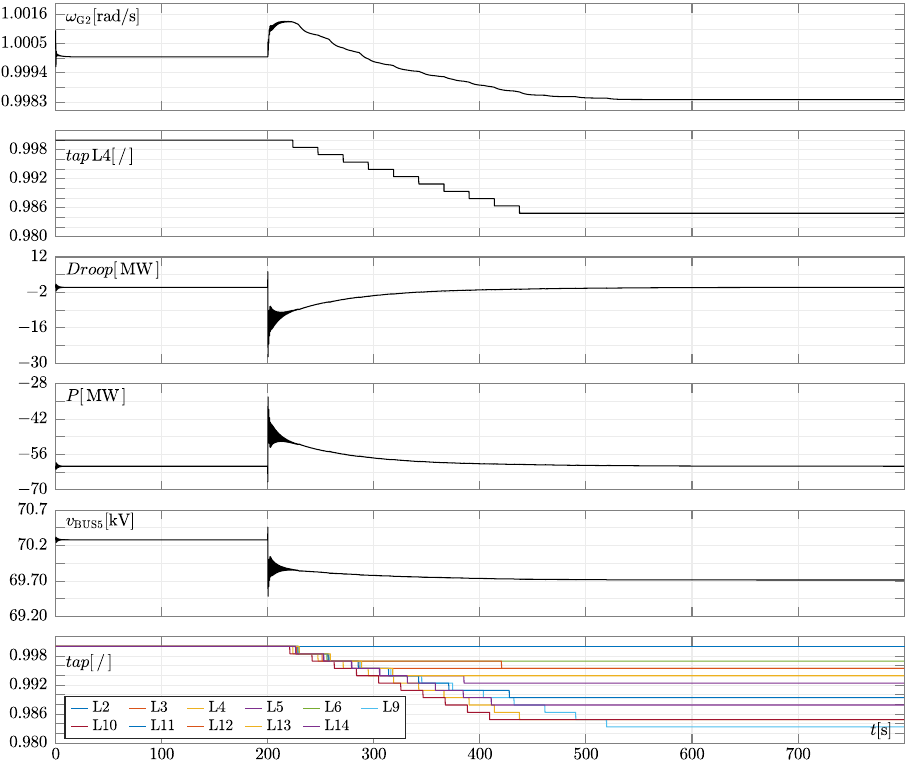
Figure 8. Simulation results of the modified IEEE 14 test system shown in Figure 6. In this case, constant impedance loads behind OLTC s and dynamic line models are used. The MMC 1 converter, which is equipped with an AC -voltage/active power droop, is set to exchange P = 60.7MW and Q = − 13MVAR (this latter value is also exchanged by MMC 2). The MMC 2 converter is equipped with a shunt capacitor. Third panel from the top: MMC 1 power exchange variation due to the implementation of the droop control. Fourth panel: overall power exchange of the MMC 1